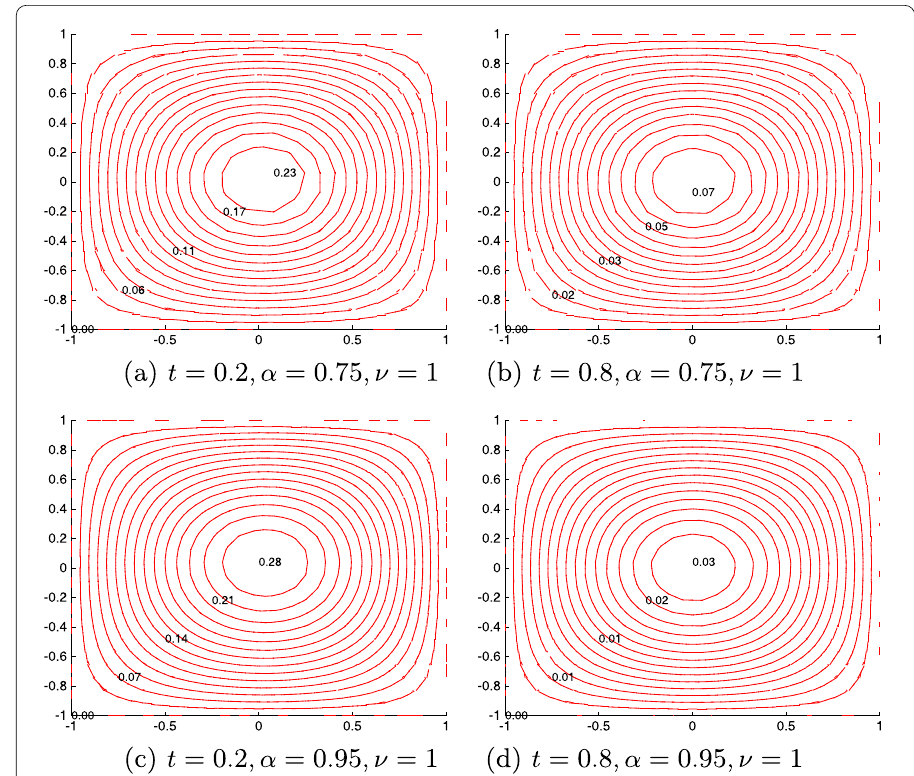
Figure 2 Solution of example 2 with different fractional orders and lowReynoldsnumber (Re = 1) and at different